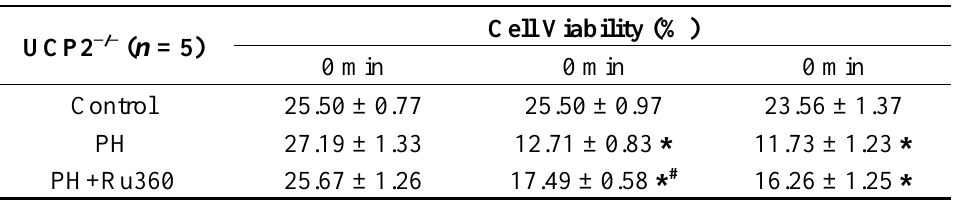
Table 2. Cell viability in UCP2 −/− .